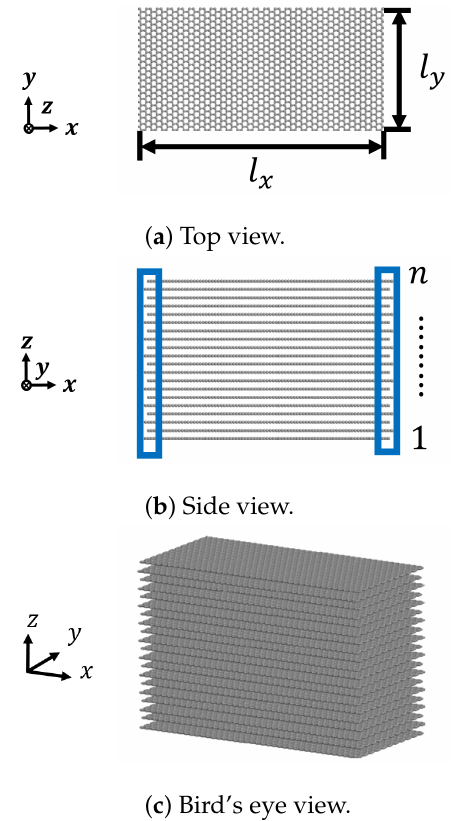
Figure 1. Atomic model of